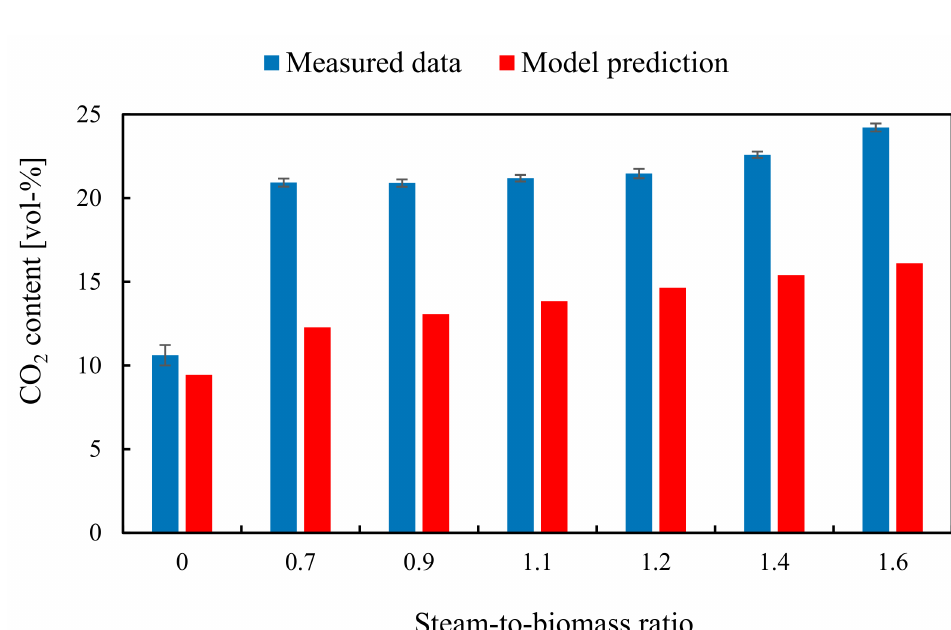
Figure 8. Effect of SBR on carbon dioxide